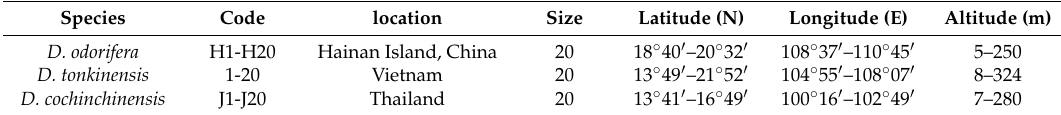
Table 1. Geographical location of the three Dalbergia